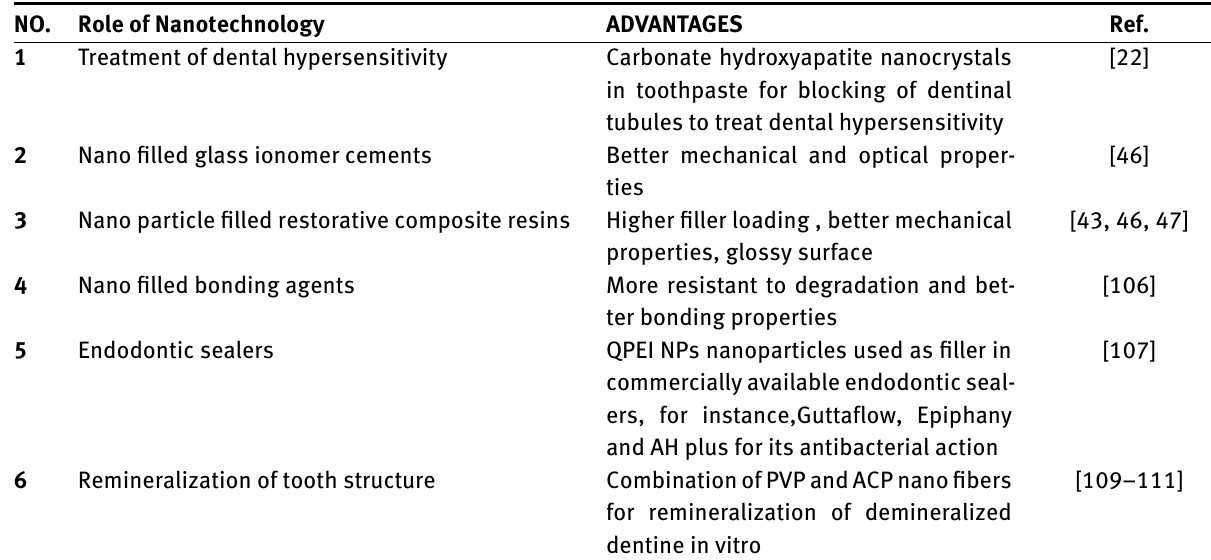
Table 2: Role of Nanotechnology in Conservative Dentistry and Endodontics